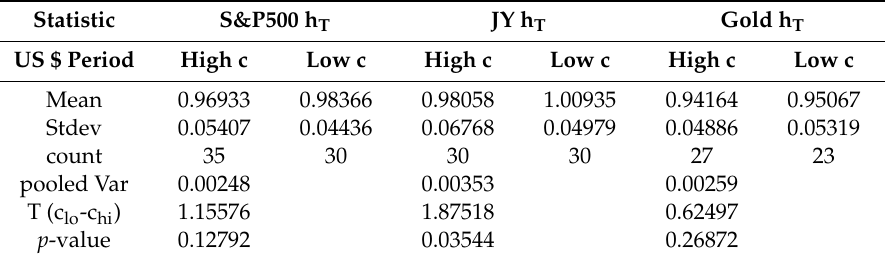
Table 3. High and low c period (US $) h T s (and their low–high period di ff erence). Statistic